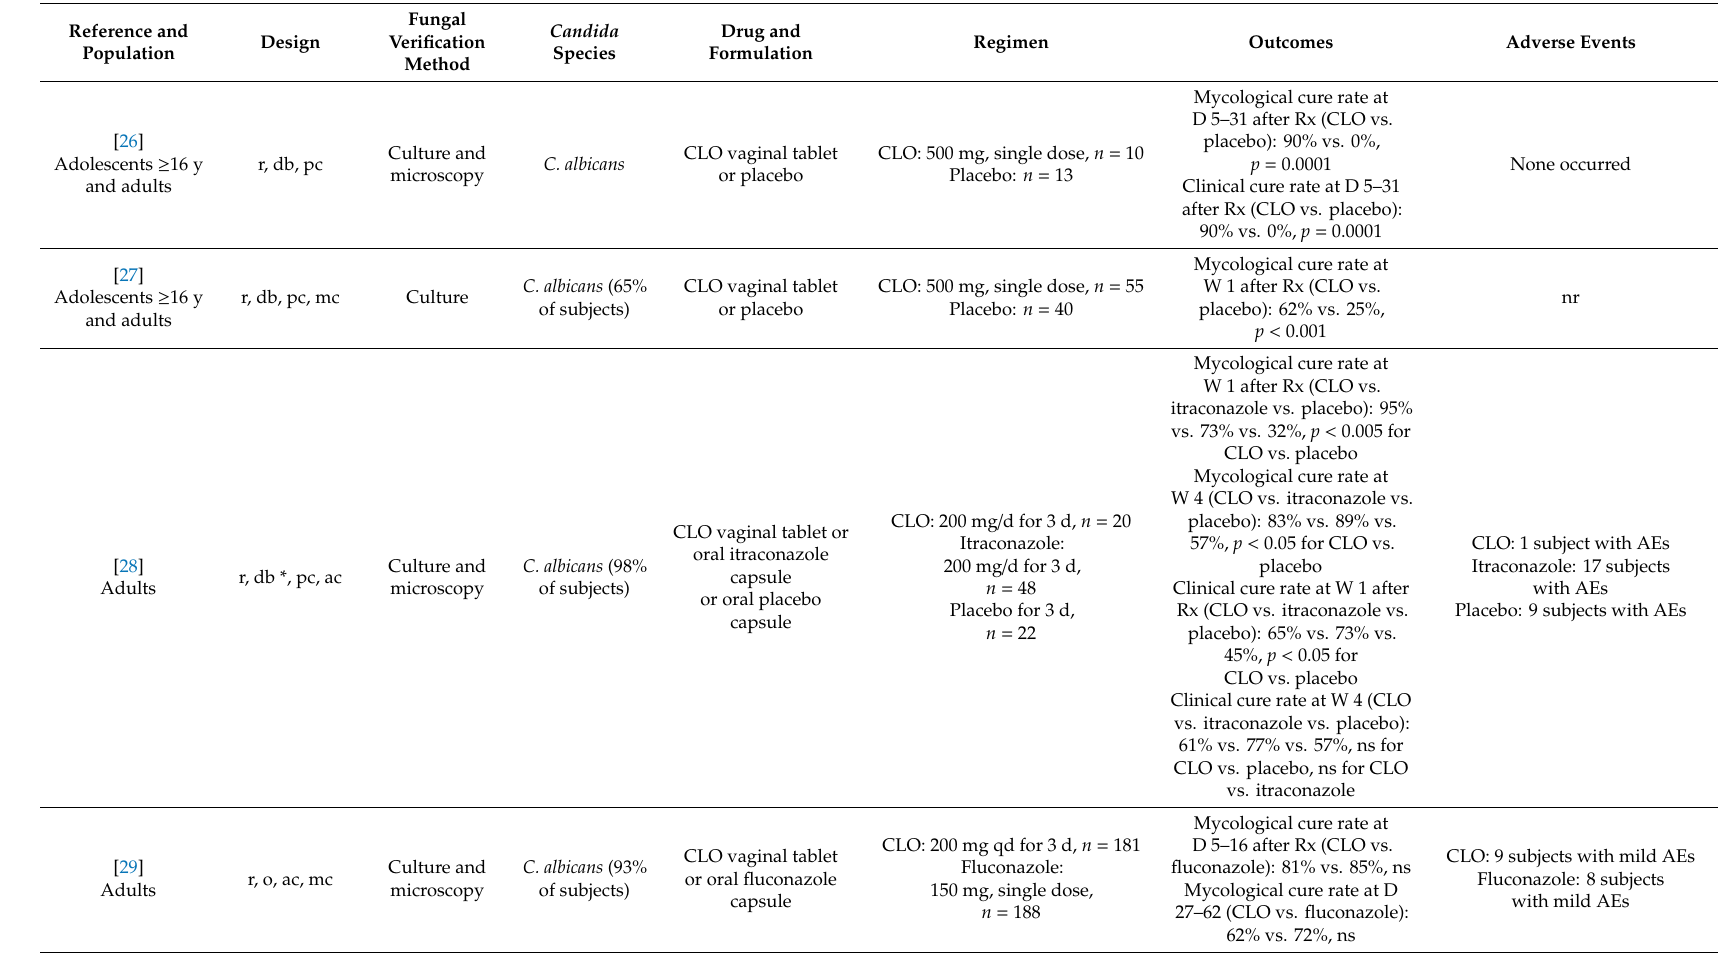
Table 1. Placebo- and active controlled studies investigating intravaginal clotrimazole in women with uncomplicated (acute) vulvovaginal